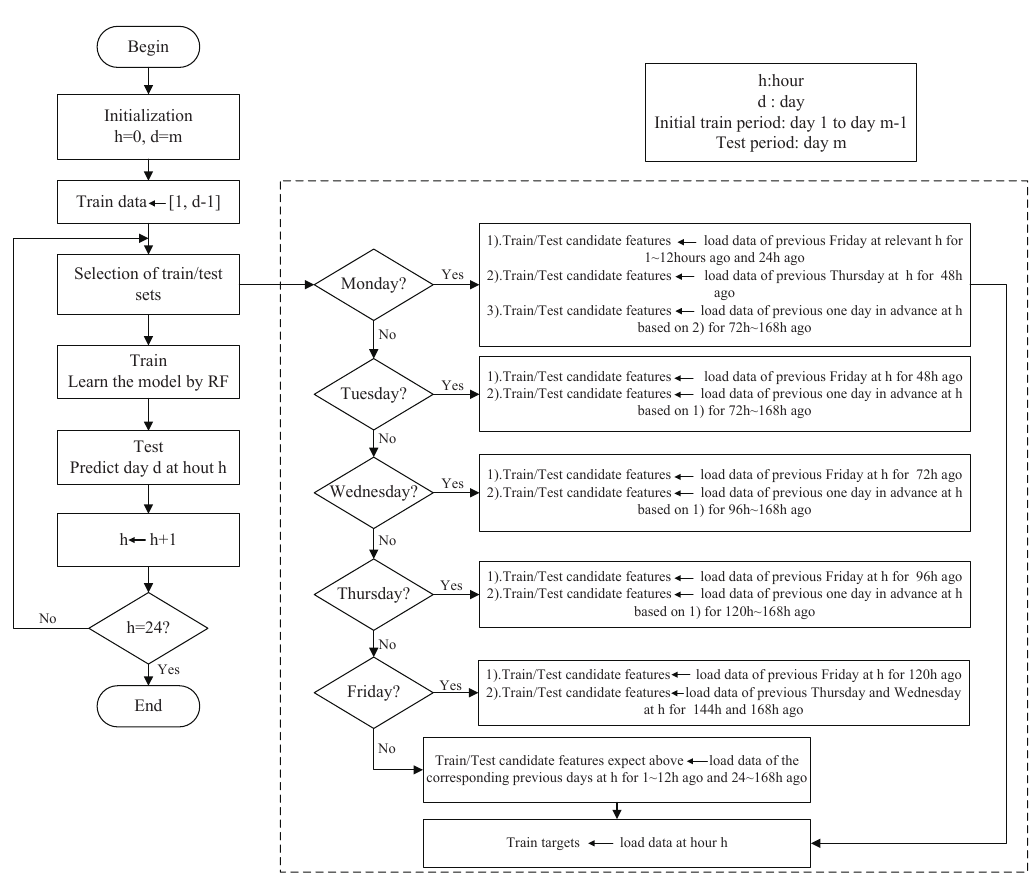
Figure 2. Flowchart of the prediction strategy with the selection of candidate